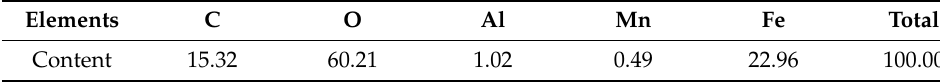
Figure 11. Enlarged morphology of gray spots in weld fusion line ( a ) zone 1; ( b ) zone 2. Table 2. Gray-spot energy-spectrum analysis results (at.%).